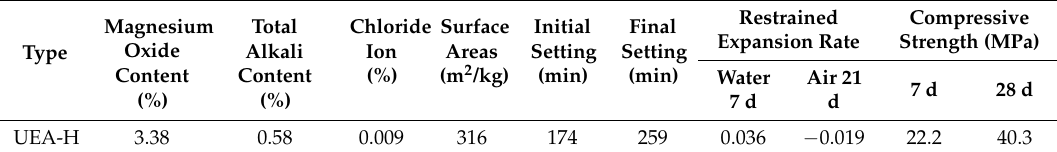
Table 3. Performance index summary of the expansion agent.